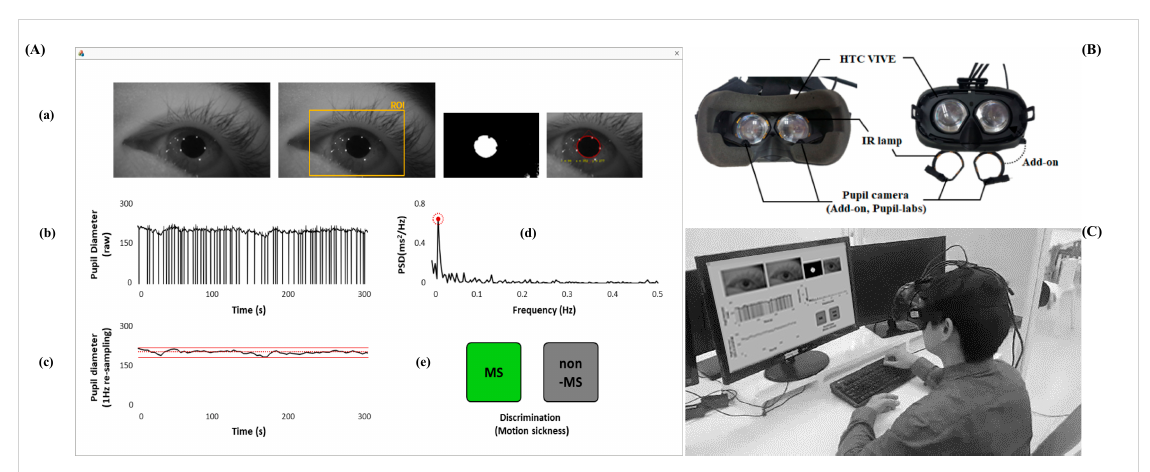
Figure 10. Flowchart for the offline training and online testing stage in the non-contact measurement system of motion sickness.